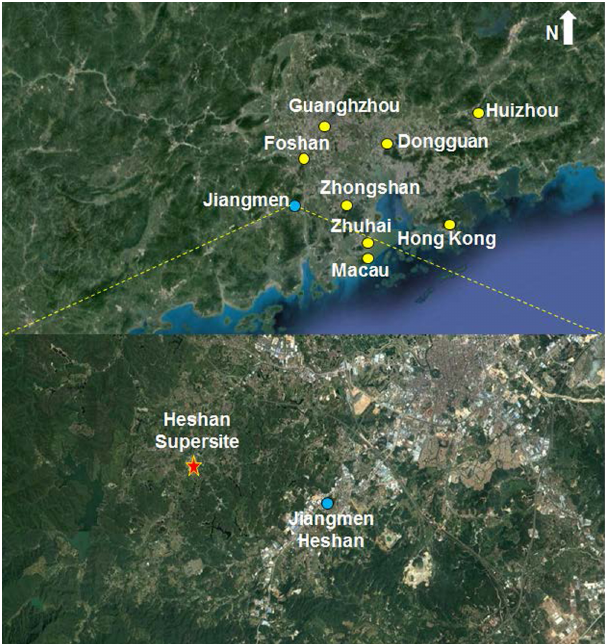
Figure 1. The sampling site and its surrounding environment in the Pearl River Delta region (top panel: overview of the site location; bottom panel: zoomed-in view, red star denotes the site location). The base map was from © Google